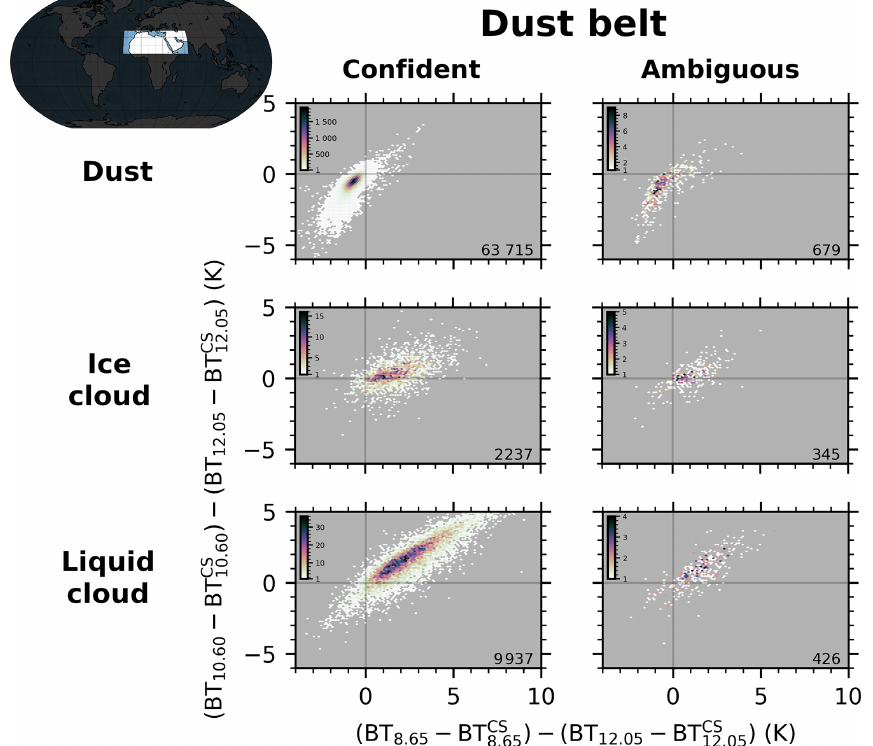
Figure 9. As Fig. 2 for dust, ice clouds, and liquid clouds detected in the dust belt region (10–38 ◦ N and 25 ◦ W–65 ◦ E) with 4 < z top < 8km and 0 . 2 < τ < 3.